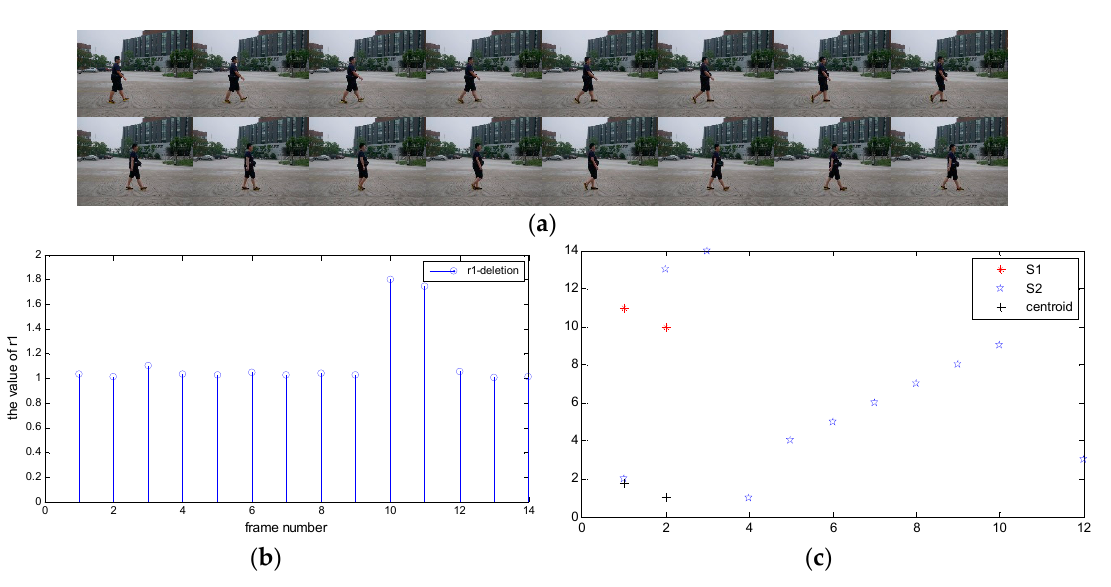
Figure 7. Frame insertion and clustering results. (a) Sixteen frames from a video tampered by frame insertion; (b) The curve of ∆r1 ; (c) clustering results.